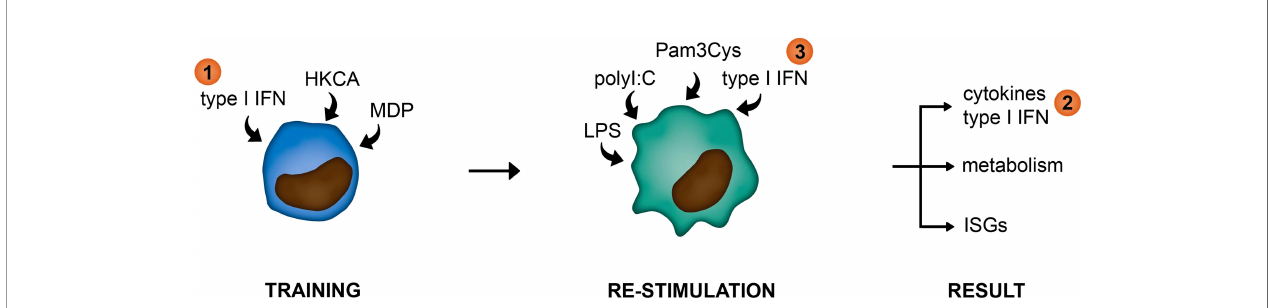
FIGURE 1 | Graphical representation of hypothesized functions of type I IFNs within the framework of trained immunity. (1) as a trainer inducing a trained immunity phenotype in innate immune cells, (2) as a result of trained immunity manifested by elevated type I IFN secretion upon re-stimulation, or (3) as a re-stimulus inducing the upregulation of IFN-stimulated